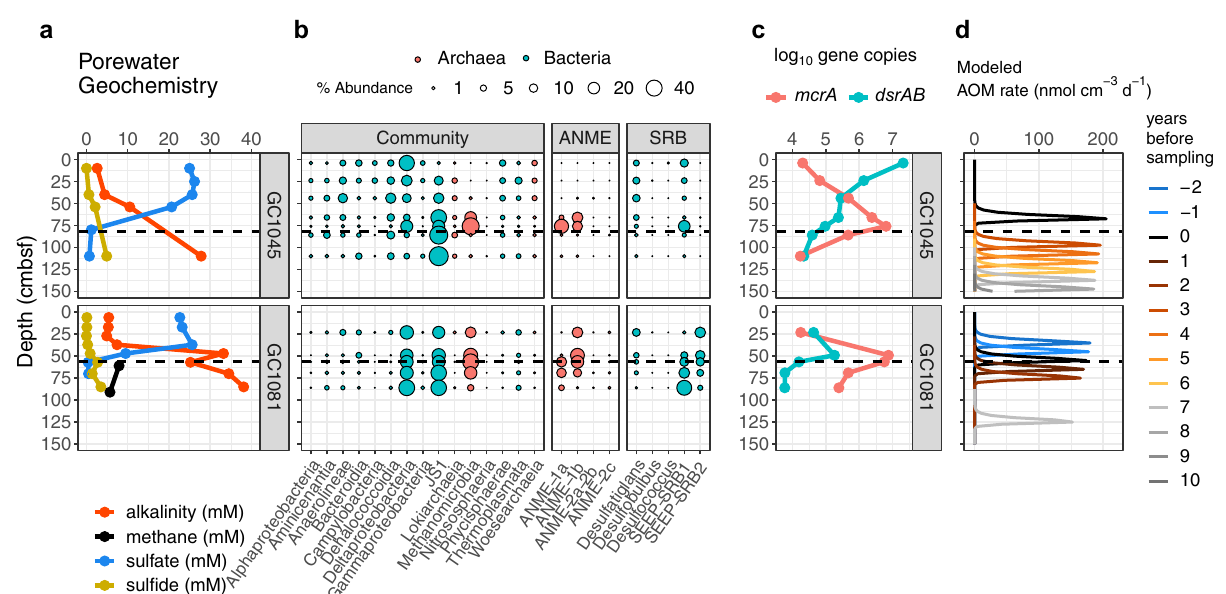
Fig. 4 Geochemical, microbial community, and gene abundance data from two sites showing sulfate-methane dynamics suggestive of recent increases in methane fl ux. Gravity cores GC1045 and GC1081 are located at gas hydrate mounds 3 and 4, respectively. Sulfate-methane transition depths in centimeters below sea fl oor are indicated by dashed lines. a shows methane concentrations and porewater sulfate, sul fi de, and alkalinity, and b indicates percent abundances of dominant bacterial and archaeal classes, dominant anaerobic methanotrophic archaeal (ANME) families, and sulfate-reducing bacterial (SRB) genera. c Copy numbers of mcrA and dsrAB genes per gram bulk sediment. d Temporal progression of modeled AOM rates from 10 years before sampling to up to 2 years after sampling.